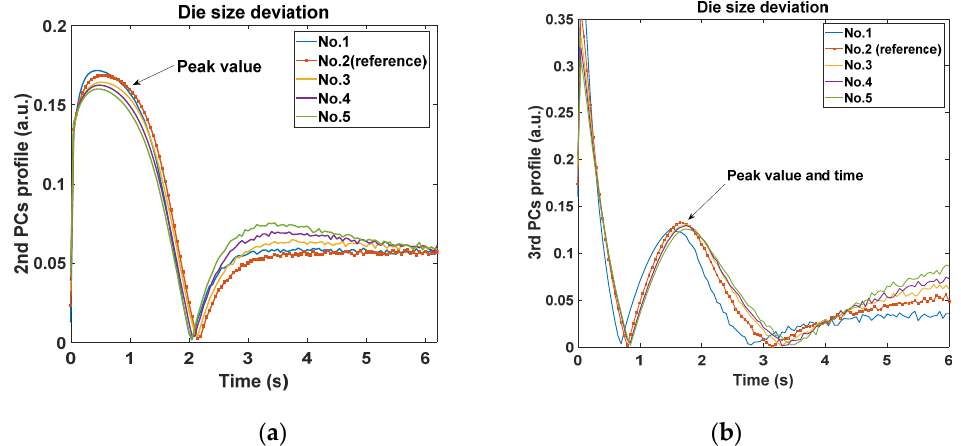
Figure 8. Comparison of features with different die sizes; ( a ) the 2nd principal component profiles; ( b ) the 3rd principal component profiles.